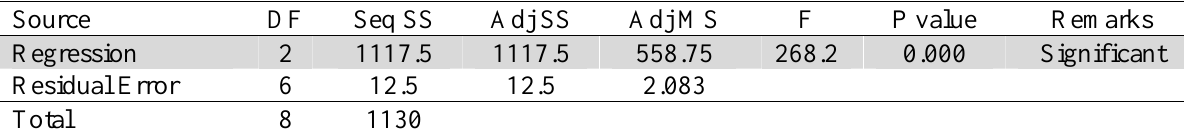
ANOVA table of 1 st order model for cutting temperature